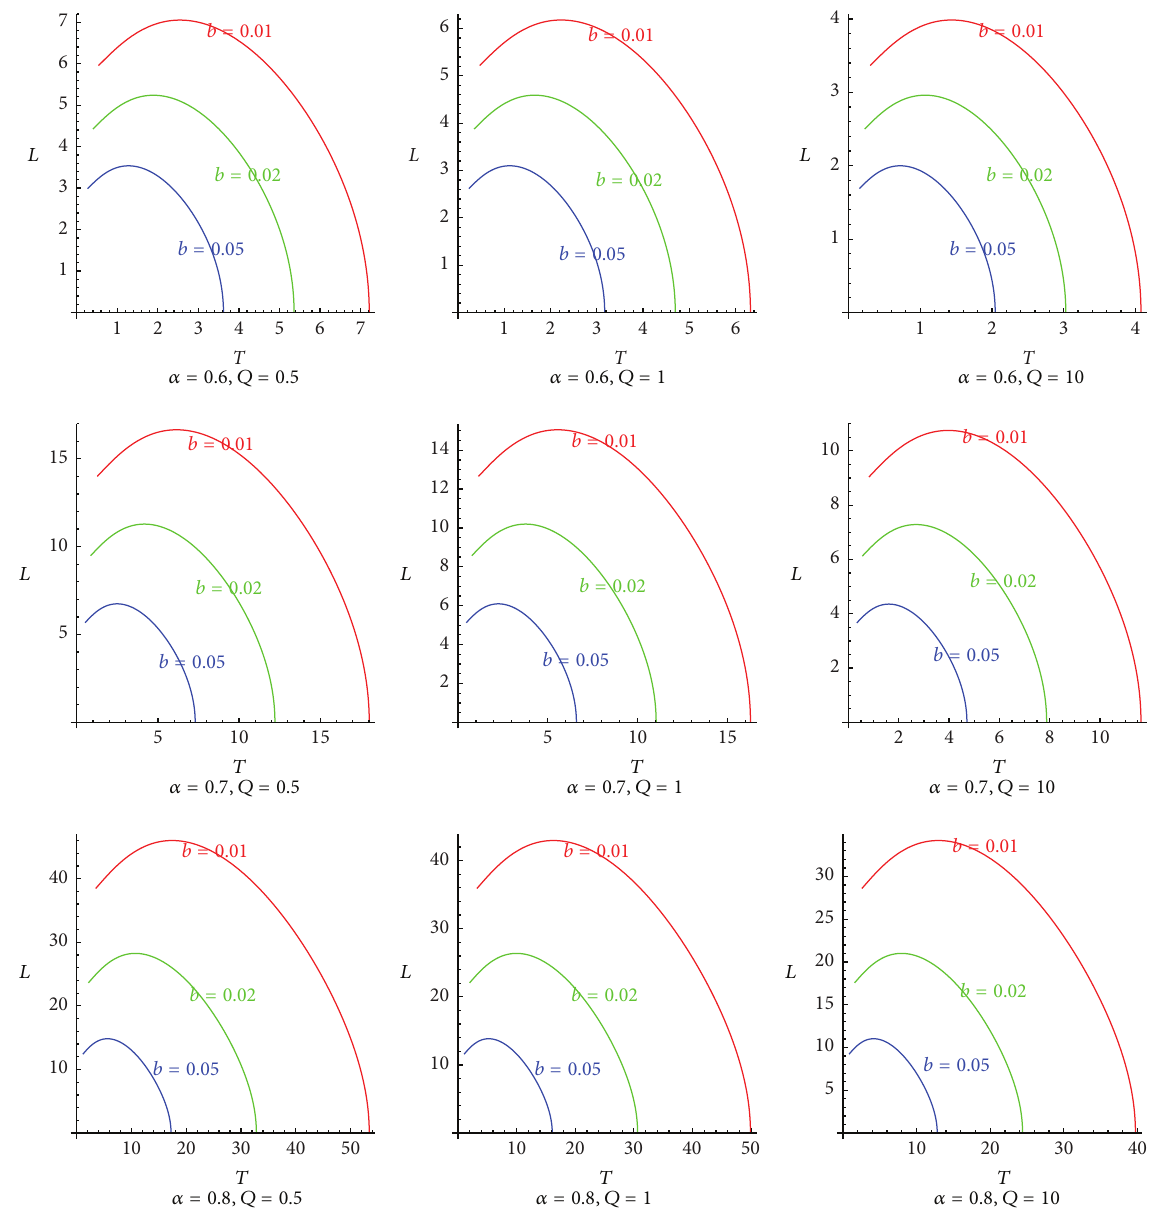
Figure 4: 𝐿 - 𝑇 curves for the topological dilaton black hole in 𝑛 -dimensional AdS spacetime as 𝑛 = 5 . In each diagram, the highest curves (red) correspond to 𝑏 = 0.01 , the middle curves (green) meet 𝑏 = 0.02 , and the lowest curves (blue) are with 𝑏 = 0.05 .